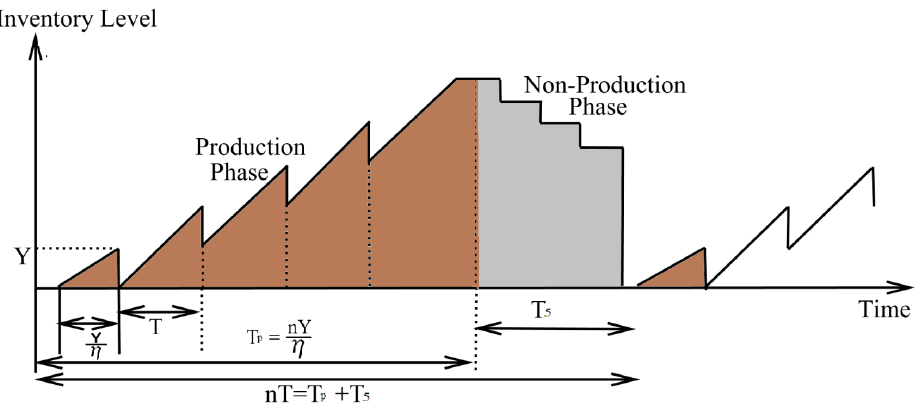
Figure 5. Representation of production and non-production systems in a supply chain model T .